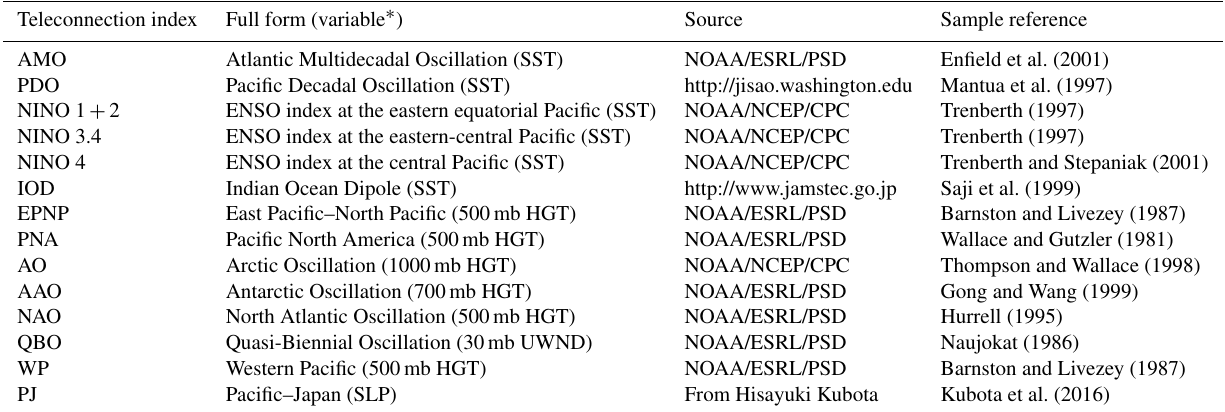
Table 2. List of the 14 teleconnection indices used in this